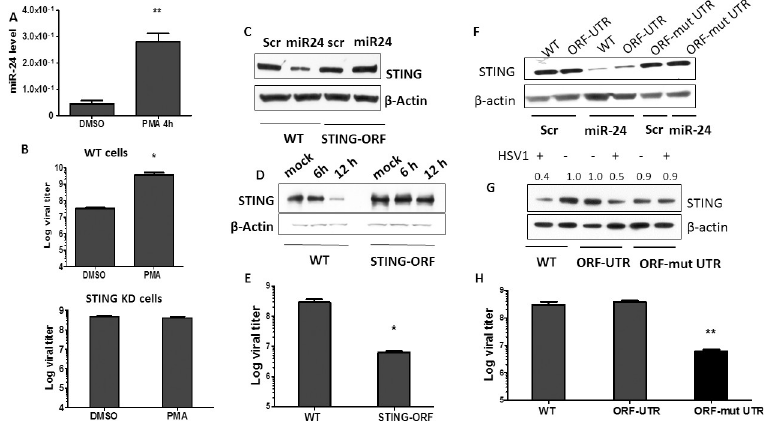
Fig 5. Pre induction of miR-24 by MAPK activator promotes viral replication and effect of miR-24 is regulated through 3’UTR of STING mRNA. (A) HT1080 cells were treated by PMA (10 μ M) and miR-24 expression was determined. (B) HT1080 cells or HT1080 STING KD cells were treated with PMA and then HSV1 infection was given 2 hours post treatment. HSV1 virus titer was quantified in cells and culture supernatants 8 hours post infection. Control group was treated with DMSO. (C) HT1080 cells and HT1080 STING KD cells reconstituted with STING-ORF were transfected by Scramble or miR-24 and cells were harvested after 24 hours to determine STING protein level by western blotting. (D) HT1080 cells and HT1080 STING KD cells reconstituted with STING-ORF were infected with HSV1 and cells were harvested after 6 and 12 hours to determine STING protein level by western blotting. (E) HT1080 cells and HT1080 STING KD cells reconstituted with STING-ORF were infected with HSV1, cells and culture media were harvested after 12 hours to determine viral titer. (F) HT1080 cells (WT), HT1080 STING KD cells reconstituted with ORF-UTR (containing STING ORF+3’UTR) and HT1080 STING KD cells reconstituted with ORF- mut UTR (containing STING ORF + mutated 3’ UTR where the binding site for miR-24 has been mutated in 3’UTR) were transfected with Scramble RNA or miR-24 and cells were harvested after 24 hours to determine STING protein level by western blotting. (G) HT1080 cells, HT1080 STING KD cells reconstituted with ORF-UTR (containing STING ORF+3’UTR) and HT1080 STING KD cells reconstituted with ORF- mut UTR (containing STING ORF + mutated 3’ UTR where the binding site for miR-24 has been mutated in 3’UTR) were infected with HSV1 and cells were harvested after 12 hours to determine STING protein level by western blotting. (Numbers above the blot represent densitometric quantification of STING normalized against actin) (H) HT1080 cells, HT1080 STING KD cells reconstituted with ORF-UTR and HT1080 STING KD cells reconstituted with ORF-mut UTR were infected with HSV1 and cells and culture media were harvested after 16 hours to determine viral titer. ( A, B, E, H— Mean ± SEM, N = 3). � P < 0.05, �� P < 0.01, ��� P <